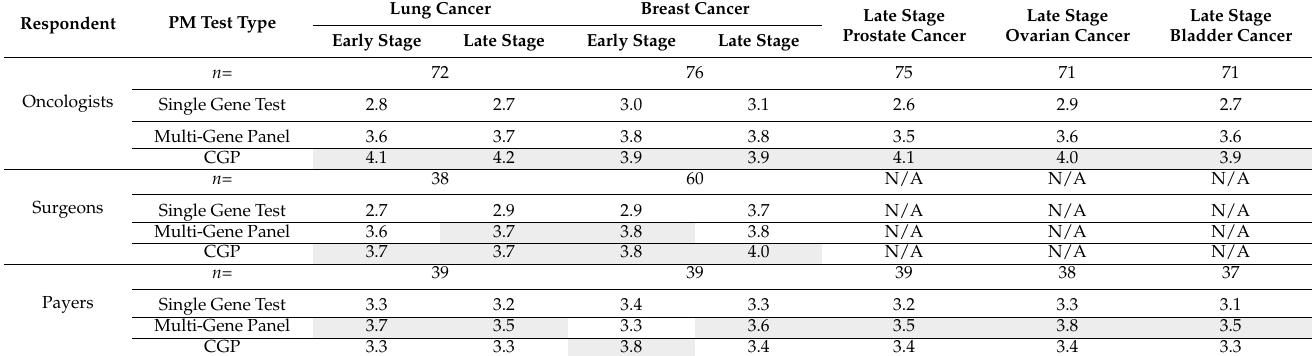
Table 2. Oncologists, surgeons, and payers ( n = 332) were asked the following questions: Please rate the clinical utility of each test for early stage breast and lung cancer on a scale of 1 to 5, where 1 is not at all useful and 5 is extremely useful. Oncologists and payers. Please rate the clinical utility of each test for late-stage cancer on a scale of 1 to 5, where 1 is not at all useful and 5 is extremely useful. The highest-ranking test for each cancer type is shaded grey. Oncologists view CGP is having the highest clinical utility for all cancers. Payers mostly view multi-gene panel testing as having the highest clinical